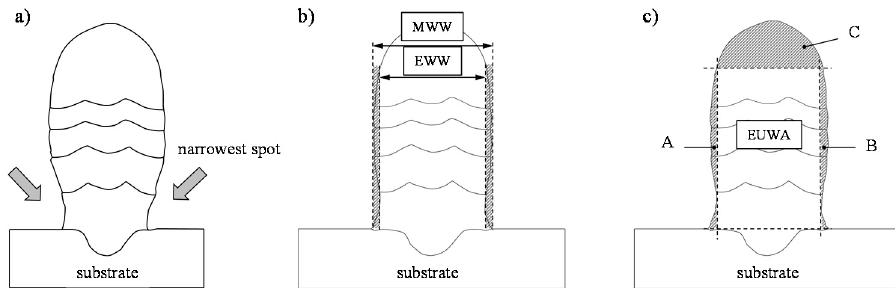
Figure 4. Schematic representation of ( a ) the characteristic development of the bead width with increasing structure height, ( b ) the maximum wall width MWW and effective wall width EWW and ( c ) the effective usable wall area EUWA.